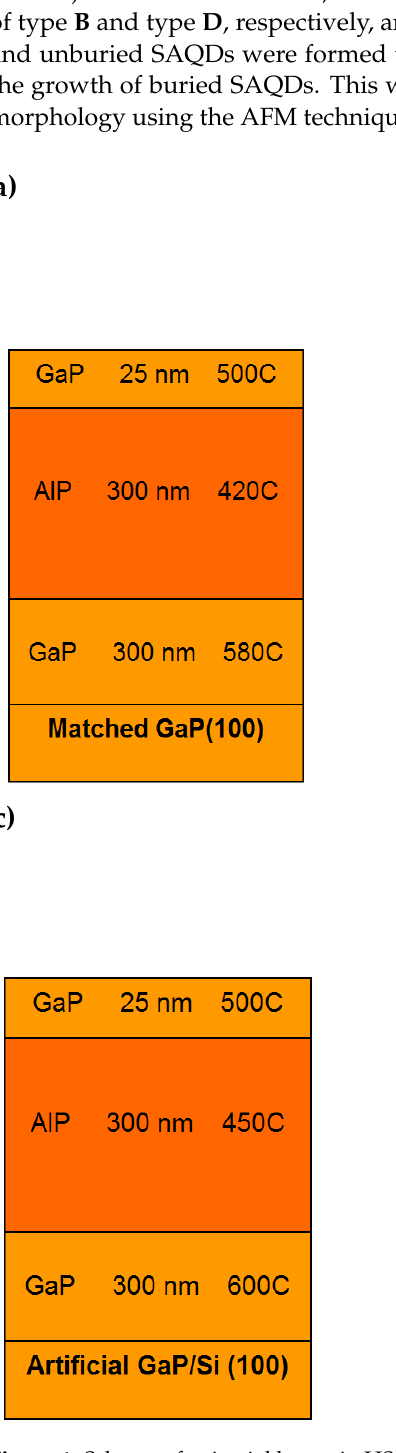
Figure 1. Scheme of epitaxial layers in HSs of various types: ( a ) test HS ( A ) without SAQDs grown on a GaP substrate, ( b ) HSs with SAQDs (type B ) grown on a GaP substrate, ( c ) test HS without SAQDs ( C ) grown on an artificial GaP/Si substrate, and ( d ) HSs with SAQDs (type D ) grown on an artificial GaP/Si substrate.